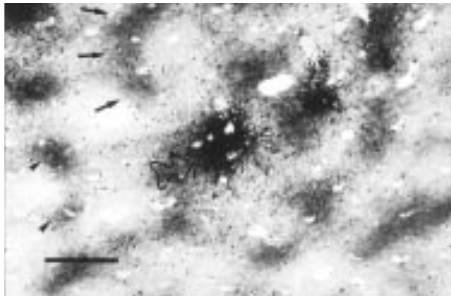
Figure 2 - Low power photomicrograph of a tangential section through V1 double labeled for biocytin and cytochrome oxidase (CYTOX) illustrating a biocytin ion- tophoretic injection site (open arrow) relative to the CYTOX blobs. Filled arrows point to a row of blobs and arrowheads point to individual blobs. Scale bar = 400 µm.